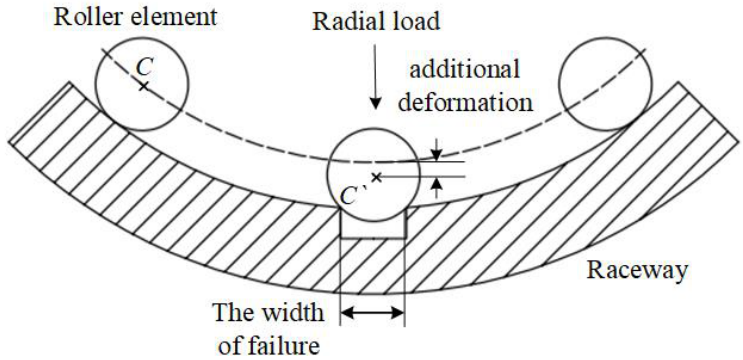
7 of 19 Figure 4. The workflow chart of fault diagnosis of multi-joint robot. 3. Dynamic Simulation of Fault States 3.1. Contact Deformation of Bearing Failure The bearing failure accounts for about 40% of mechanical failures according to the survey, and over 90% of the faults in rolling bearings occur in the inner and outer raceway [22]. Therefore, the types of bearing faults analyzed in this work are mainly single-point faults occurring in the inner and outer rings of bearings. It is assumed that the inner race keeps rotating at a constant speed and the outer ring is stationary under the external radial load. Each ball performs pure rolling without slip, and the effect of weight is ignored. The scratch defect model of the raceway surface of the inner and outer race of the bearing is shown in Figure 5. At the early stage of the scratch formation, the defect is usually localized so that the roller elements will pass through the defect area without touching the bottom [23]. When the roller element is in contact with the damaged point on the raceway surface, an additional elastic deformation will be generated. Due to the Hertz theory, the additional contact force 𝑃𝑃 caused by the defect is calculated as follows [24]: 𝑃𝑃 = 𝜋𝜋𝜋𝜋𝜋𝜋� 2 𝜀𝜀𝜀𝜀𝛿𝛿 3 9 𝐹𝐹 3